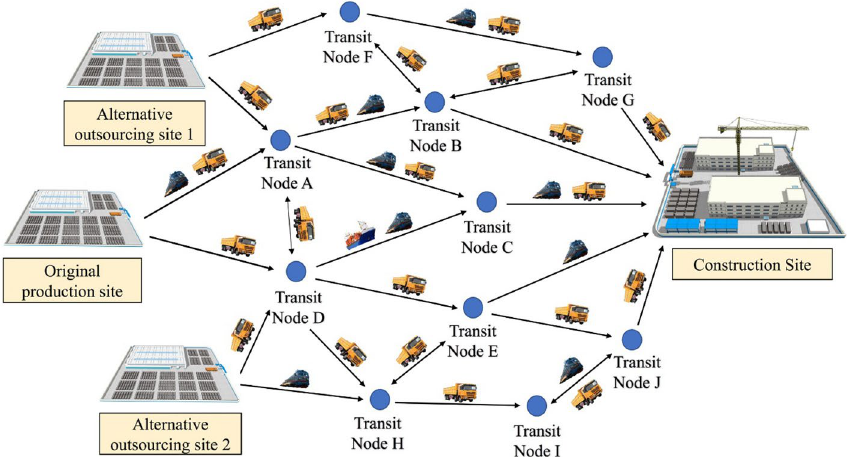
Figure 7. Potential transportation network of the PCSC for the precast construction